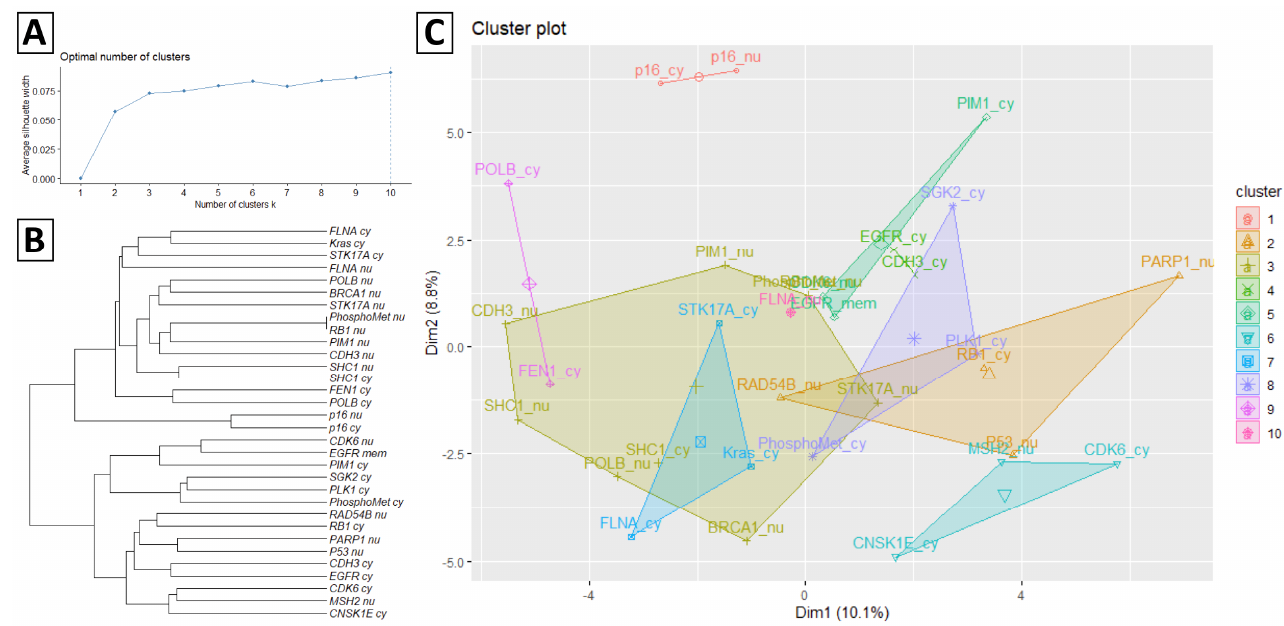
Figure 2. Ward’s agglomerative hierarchical results of the protein staining expression matrix. ( A ) The average silhouette width of each cluster and the dash line indicates the optimal number of clusters according to the silhouette index. ( B ) Dendrogram of hierarchical clustering results of 32 protein staining. ( C ) Cluster plot of protein staining coloring according to the assigned cluster. Table 2. Distribution of died and progressed subjects according to the agglomerative distance dichotomous